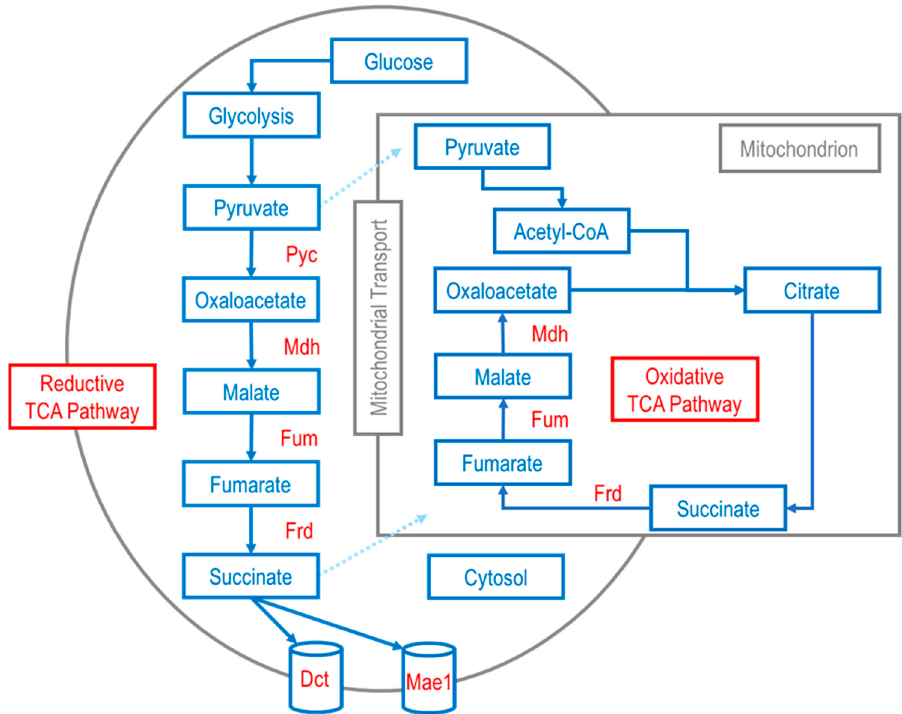
Figure 3. Example schematic of metabolic pathway(s) for C4 dicarboxylic acid production (succinate/succinic acid; fumarate/fumaric acid; malate/malic acid) in eukaryotes via the oxidative TCA pathway in the mitochondrion and the reductive TCA pathway in the cytosol. Enzymes of the depicted oxidative and reductive TCA pathways: pyruvate carboxylase (Pyc); malate dehydrogenase (Mdh); fumarase (Fum); fumarate reductase (Frd). Transport of C4 dicarboxylic acids out of the cytosol is aided by voltage-dependent slow-anion channel transporter (SLAC1) proteins transporters such as Mae1 and Dct. Adapted from previously published work [98,99,101].